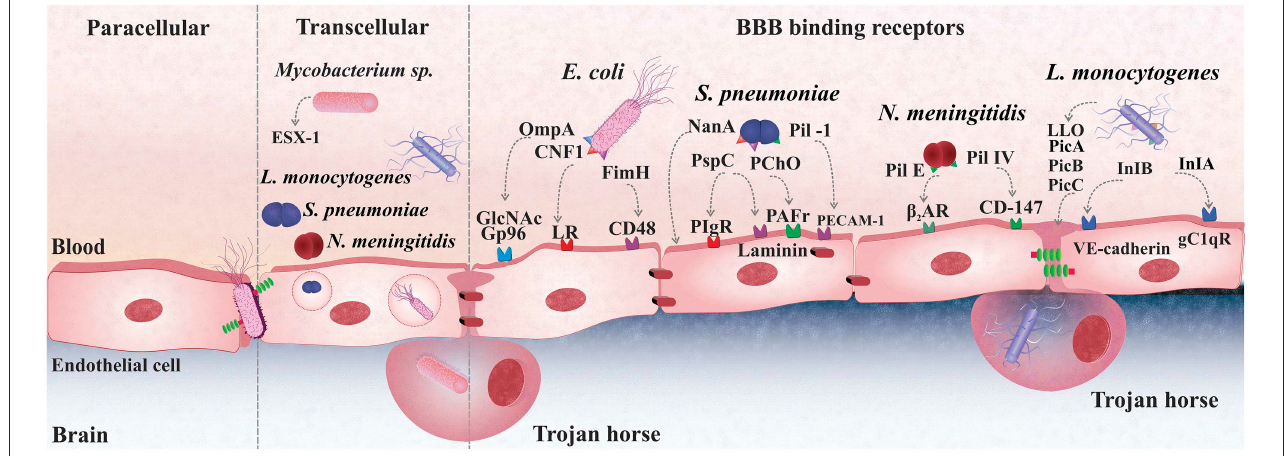
FIGURE1 Bacterial mechanisms cross the blood-brain barrier (BBB). S. pneumoniae (pneumococcus) uses the pilus-1 and PspC (CbpA) to bind to PECAM-1 and pIgR expressed on the plasma membrane of brain endothelial cells; The PAF receptor plays also a role in pneumococcal adhesion to the BBB endothelium, although whether bacteria directly to it is still unclear; The laminin receptor (LR) mediates the passage of pneumococci from the basement membrane of the BBB endothelium promoting bacterial translocation into the brain. E. coli crosses the BBB via transcellular traversal or paracellular traversal. E. coli also binds with CD48 on brain microvascular endothelial cells via a type 1 fimbrial adhesion (FimH), outer-membrane protein A (OmpA) via N-acetylglucosamine (GlcNAc) or glucose-regulated protein-96 (Gp96), and cytotoxic-necrotizing factor 1 (CNF1) via the laminin receptor (LR). L. monocytogenes disrupts the phagosome membrane, releasing the phospholipases phosphatidylinositol-specific phospholipase C (Pic)-A and PIcB, as well as the toxin listeriolysin O. Internalin (Inl)-A and Inl-B bind to endothelial cells’ receptors for the globular head of the complement component C1q (gC1qR) or VE-cadherin to cross the BBB. Mycobacterium tuberculosis infects brain tissue free or inside of macrophage, trojan-horse mechanism. The second mechanism is an active process that depends on an intact ESX-1, also known as type VII secretion systems, that induces phagosomal rupture in host phagocytes during transcellular migration. N. meningitidis uses Type IV pili and Opa, Opc binding proteins to adhere onto the mucocutaneous cells and uses Factor H to inhibit the alternative, complementary pathway.